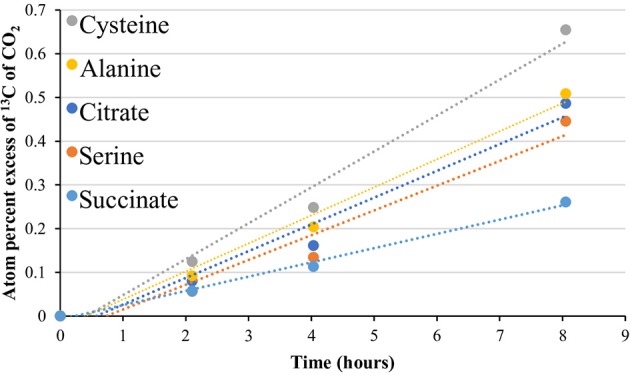
13CO2 production from uniformly labeled 13C citrate, serine, cysteine, alanine, and succinate. Symbols represent the average APE (n = 3) for a given compound at the given time. R2-values ranged from 0.961 to 1.0. The standard error is not shown for simplicity. See Table S11 for slope and linearity data for all uniformly 13C-labeled compounds and replicates for each site, and raw δ13C of CO2 values for the time course. Compounds were tested at the 85°C site only.